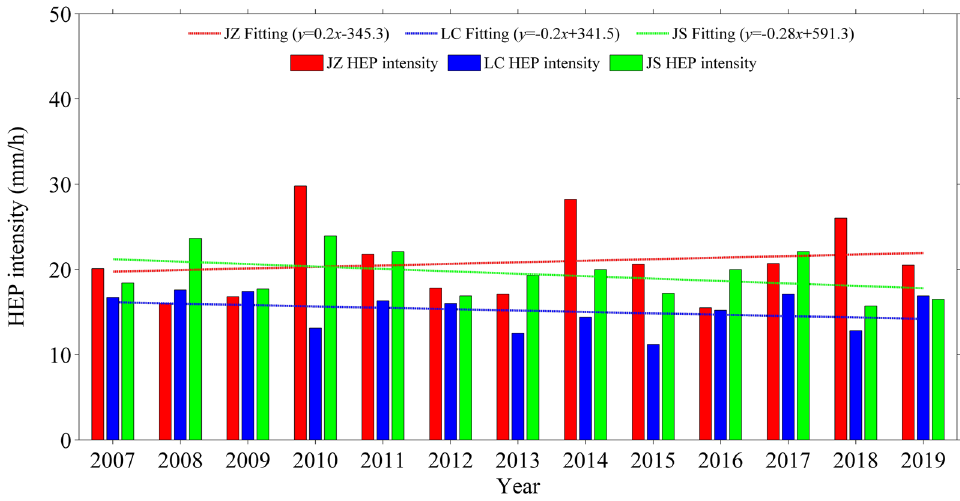
Figure 10. Interannual variations of summer HEP intensity at JZ, LC and JS stations during